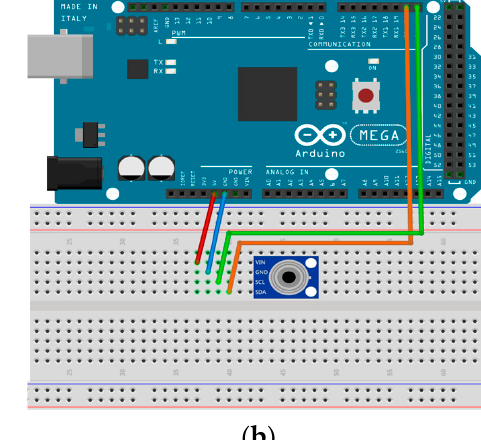
Figure 3. HEAT MLX90614: ( a ) Indoor module and wire connections of one MLX90614 sensor with the Arduino Mega ( b ).